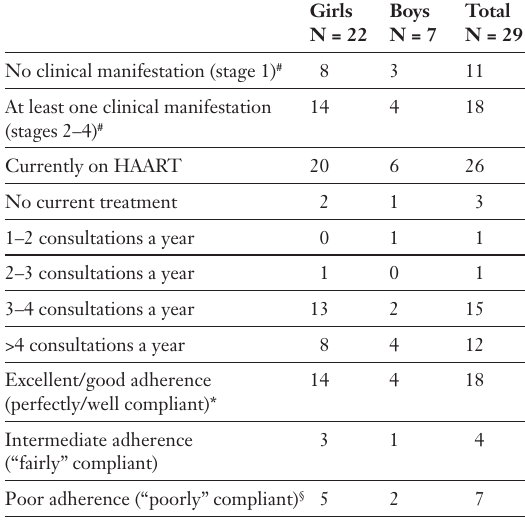
Selected clinical characteristics of the sample, including the assessment of therapeutic adherence by the